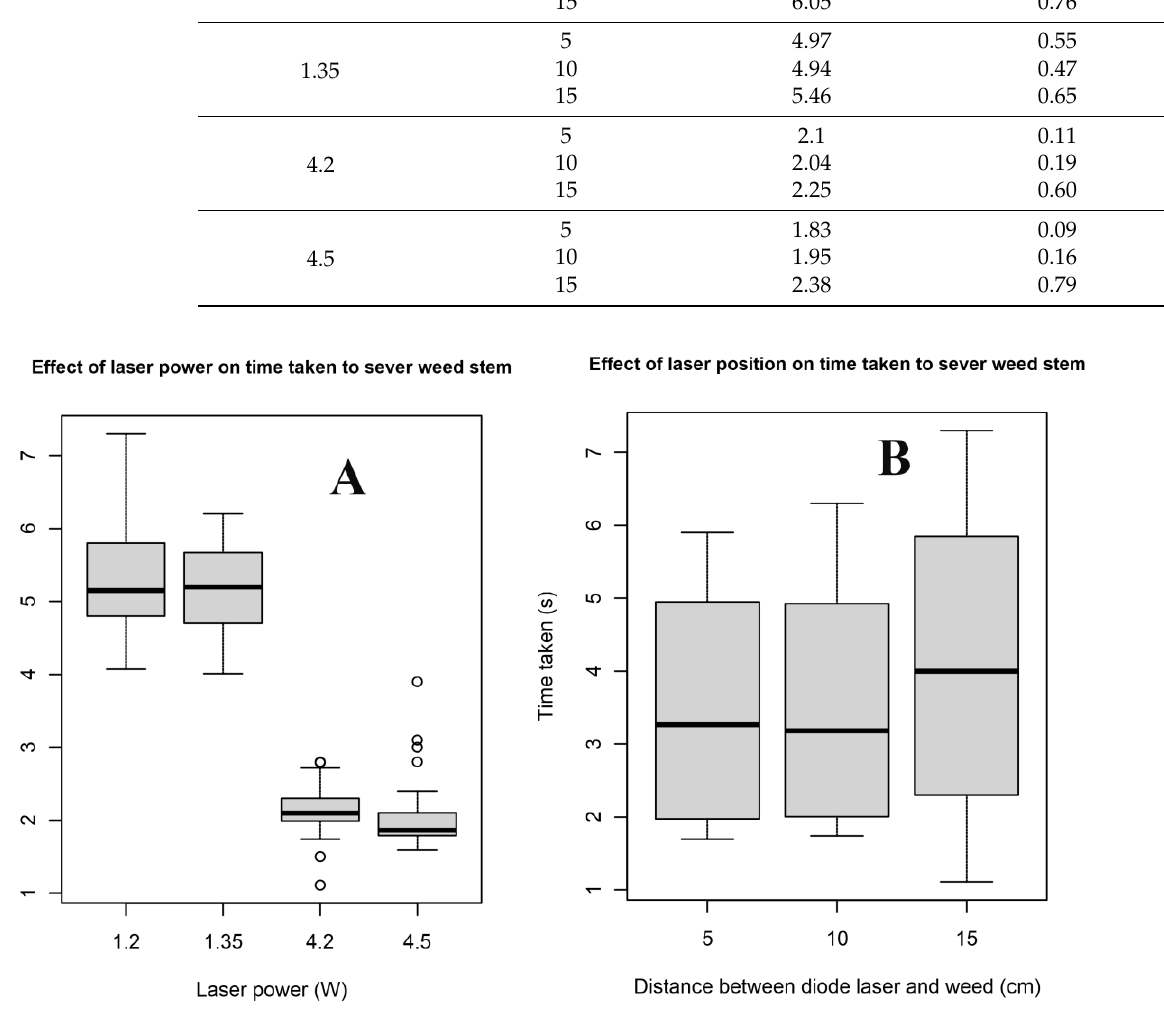
Figure 6. Box and whisker plots of the time taken to cut the weed stem vs. three factors, and the diameter data for each weed species. ( A ) shows the laser power effect where the error bars for first class (1.2 and 1.35W) lasers overlap significantly, likely, the second class (4.2 and 4.5W) lasers over- lap, while the two classes not overlapping, hence the statistical significant difference between the classes while no difference within classes, ( B ) shows the effect of distance between laser diode and weed stem where the error bars overlap more between 5 and 10cm with less overlap at 15cm which caused the statistical difference, ( C ) represents the effect of species where the error bars overlap with no statistical difference, and ( D ) represents the diameters data for each weed species with palmer amaranth having slightly higher average diameter than smallflower morningglory.